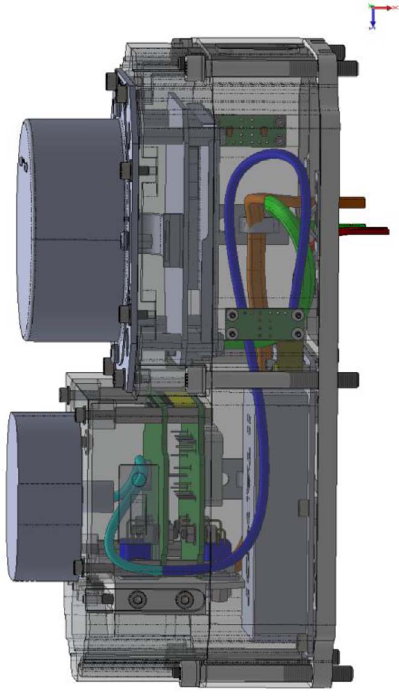
Fig. 13. Computer aided design (CAD) model showing how the IRIS payloads are secured within the three-part clam-shell structure.